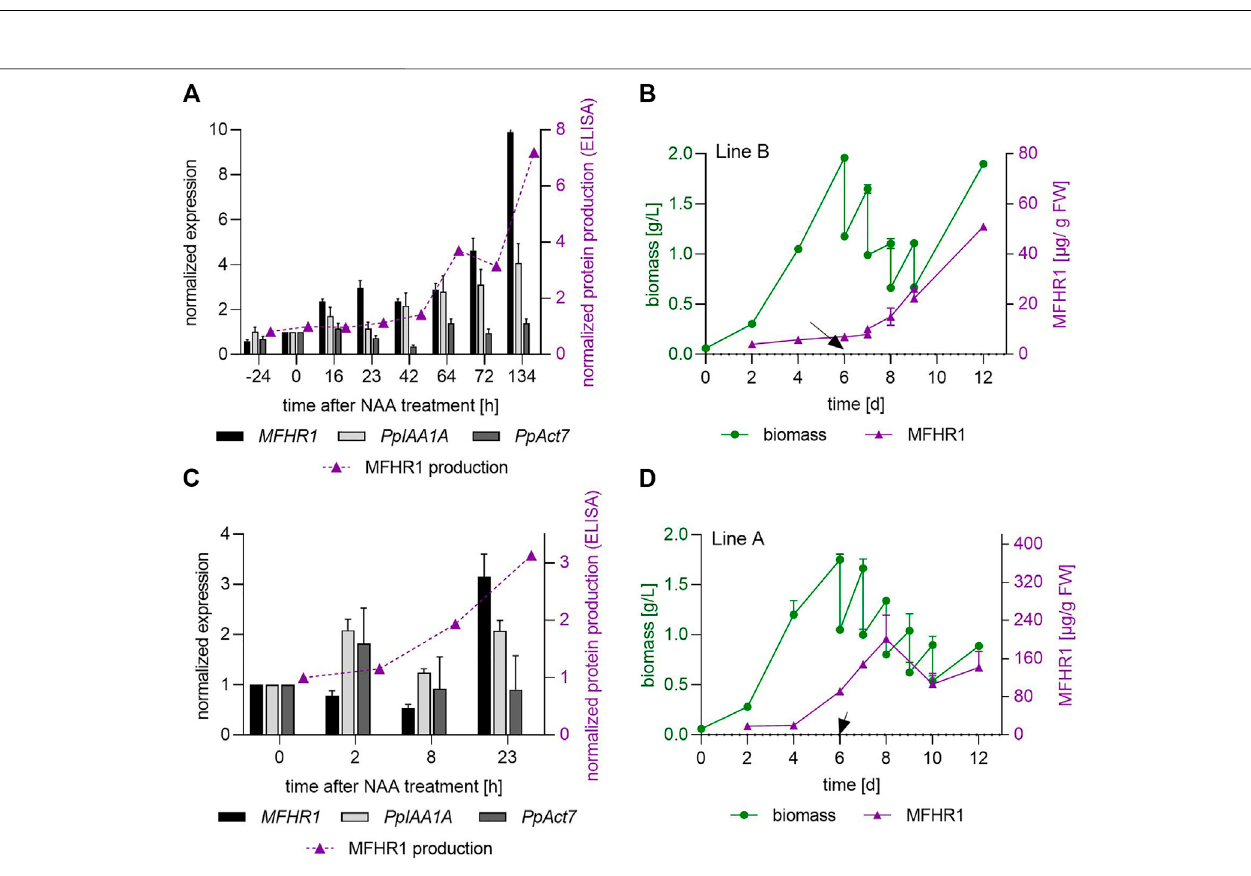
FIGURE 5 | MFHR1 transgene is upregulated during the whole growth kinetics, however, it is not rapidly induced upon auxin treatment. (A,C) . Expression of Aux/ IAA gene ( PpIAA1A : Pp3c8_14720V1.1), PpAct7 (Pp3c3_33410V3.1) and MFHR1 determined by qRT-PCR in 10 µM NAA-treated bioreactor samples. Data were normalized using two reference genes (coding for EF1- α and 60S ribosomal protein L21) and a time point immediately before NAA addition was used as calibrator. A comparison between the protein accumulation measured by ELISA and the expression of mRNA by qRT-PCR is included. Protein production quanti fi ed by ELISA wasnormalizedwiththeamountproducedimmediatelybeforeNAAaddition.Mean±standarddeviations(SD)fromthreetechnicalreplicatesareshown. (B,D) .Biomass and speci fi c MFHR1 production in a semi-continuous bioreactor process with 0.4 d − 1 dilution rate. Semi-continuous operation started at day 6 and 10 µM NAA were added. NAA was added daily to keep the concentration stable. (A,C) Data obtained from the bioreactor shown in (B,D) . The arrow indicates the fi rst addition of NAA.